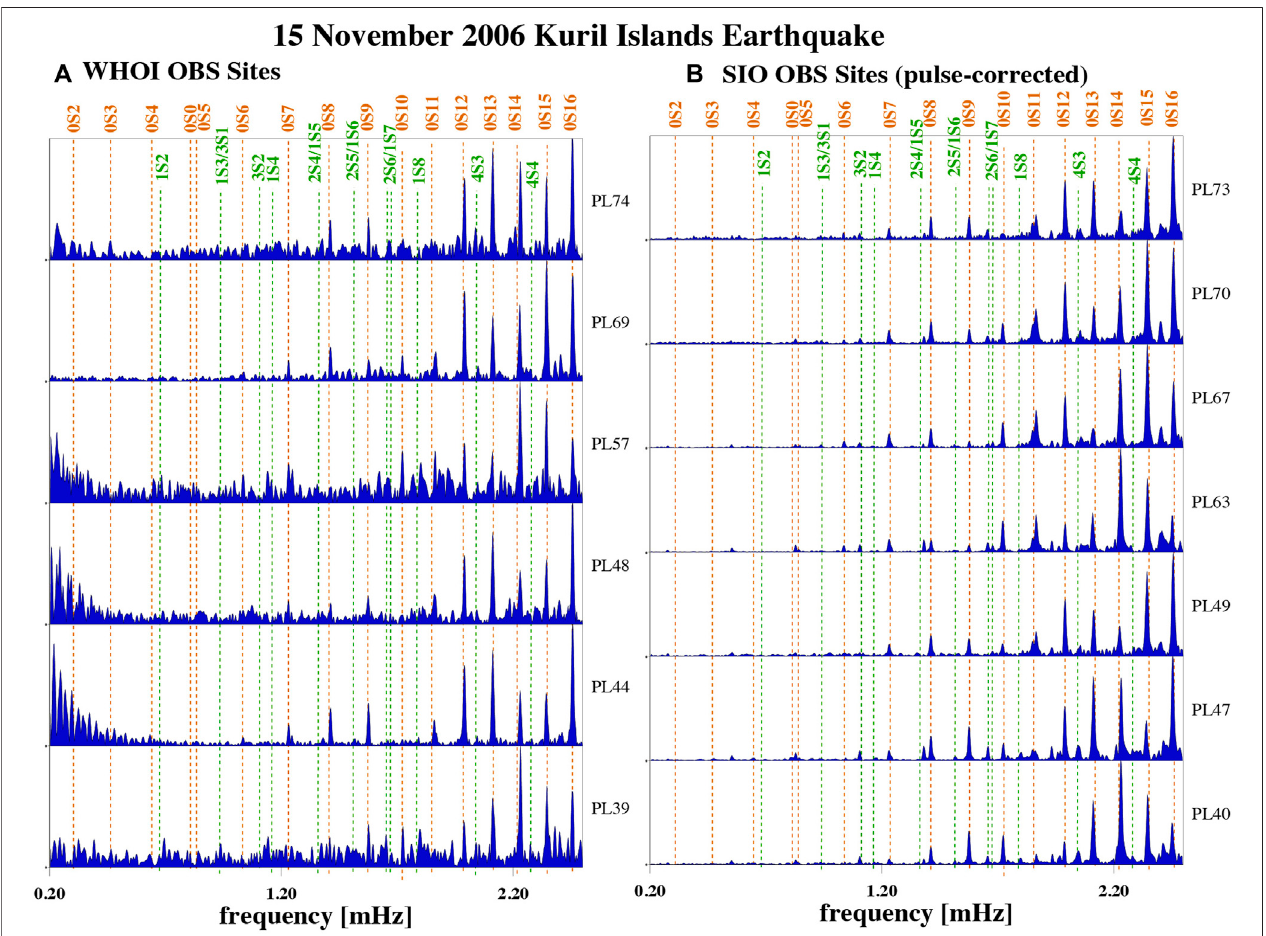
FIGURE 7 | Normalized raw vertical-component spectra for the November 15, 2006 Kuril Islands earthquake of 50-hour long segments, starting 1.5 h after the event time. (A) Spectra at the six best WHOI OBS sites. The recording sensor was aCMG-3T. (B) Spectra at seven ofthe eight SIO OBSsites. The 8th instrumentfailed earlier and did not record seismic data at the time. The recording sensor was a T-240. For event details see Figure 6 . The SIO spectra have been corrected for instrument-generated harmonic signals (see text for detail).